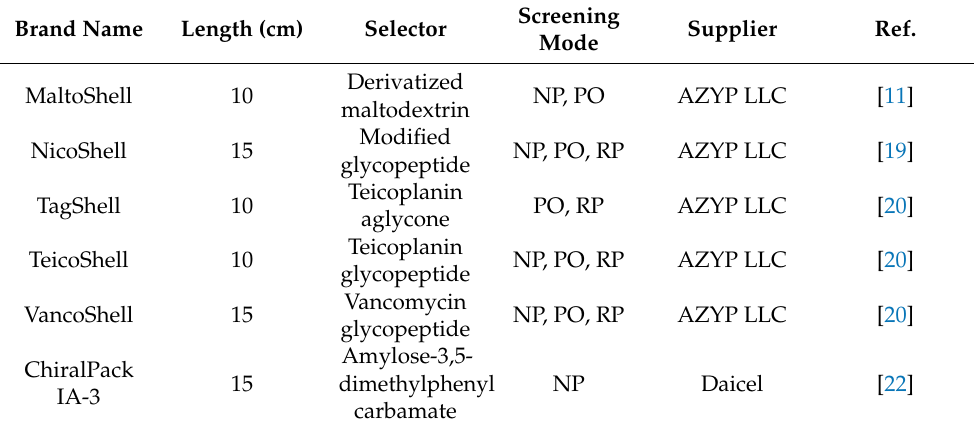
Table 1. Characteristics of the 4.6 mm i.d. chiral columns used in this work and the 3.0 mm i.d. NicoShell column.